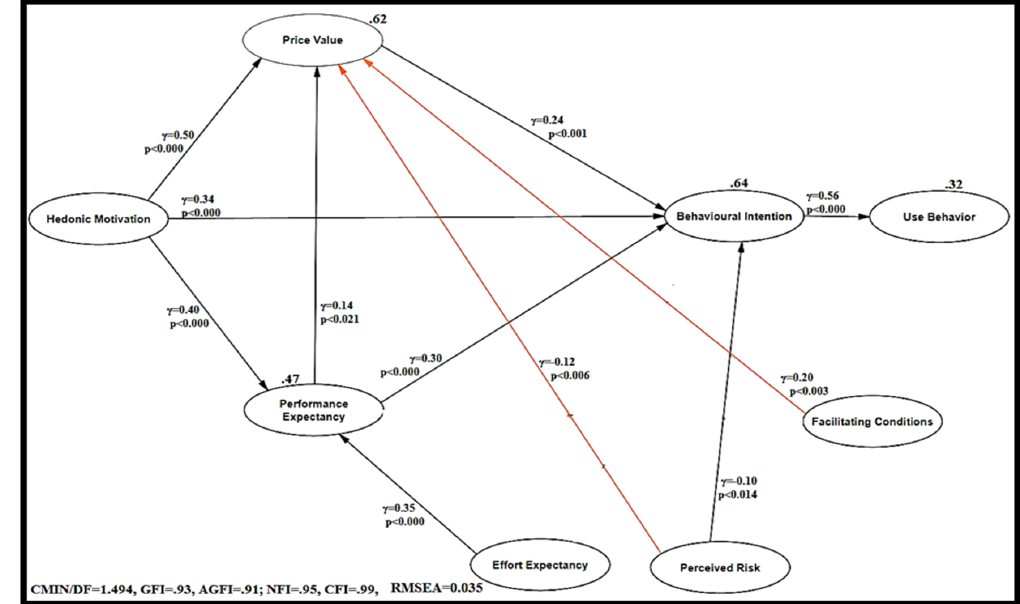
Fig. 3. Mobile Banking SEM Final